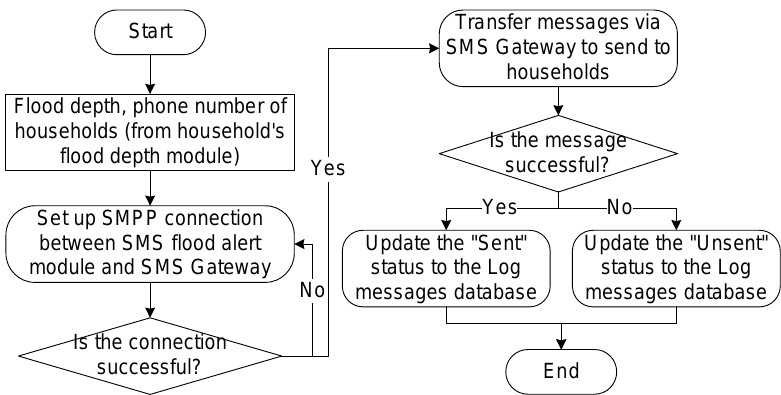
Figure 17. Operation process of short message service (SMS) flood alert module.